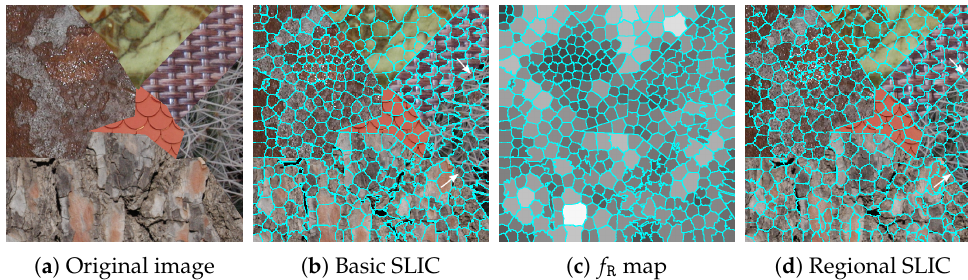
Figure 1. SLIC pre-segmentation results ( P = 400 superpixels). f R in ( c ) is rescaled to [[ 0,255 ]] . SLIC: simple linear iterative